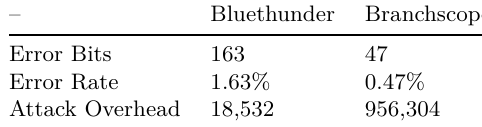
Table 7: Comparison between the two measurements in SGX, including both the accuracy and the latency. Detection Times 5 10 15 20 25 30 Rdpmc Error Rate (%) 20.5 Rdpmc Latency ( × 10 4 cycles)